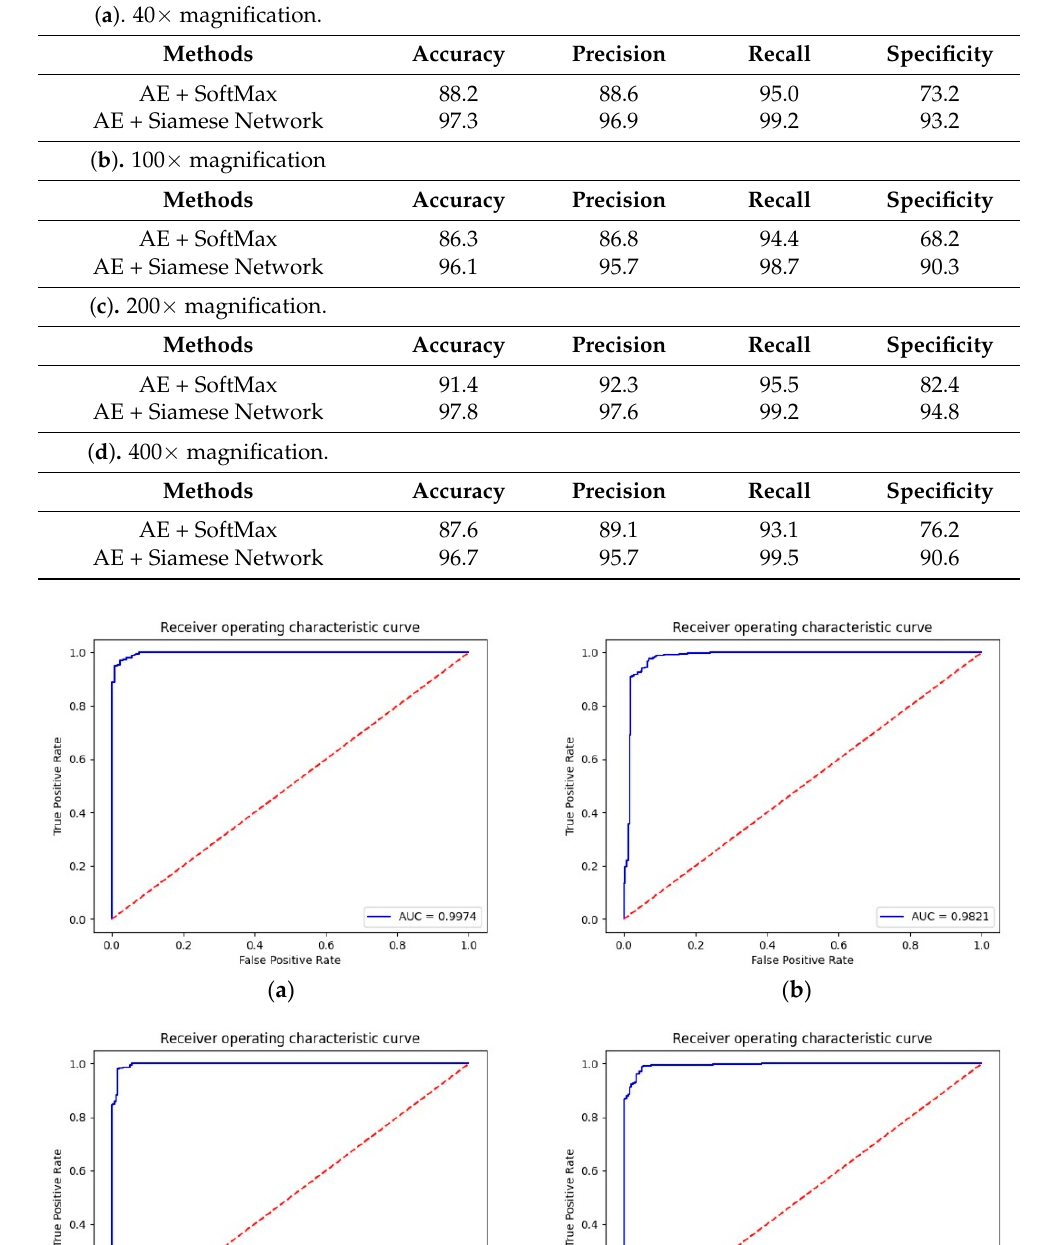
Table 2. Comparison of the performance (%) of AE + SoftMax with AE + Siamese Network. ( a ). 40 × magnification.